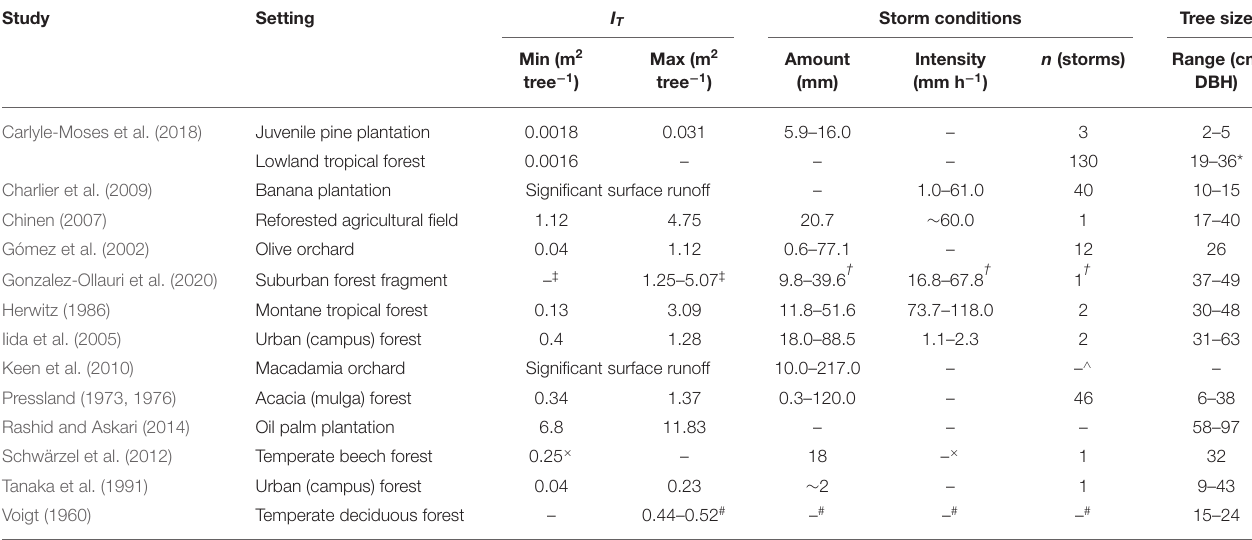
TABLE 1 | Stemflow infiltration areas ( I T ) reported from previous